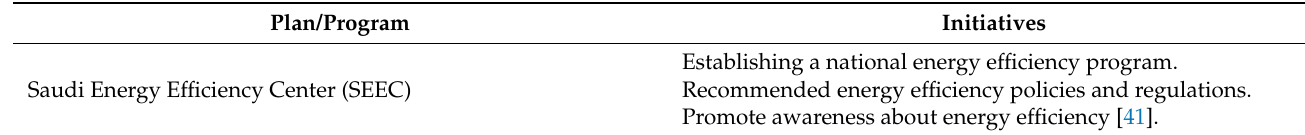
Table 3. Energy saving initiatives in Saudi